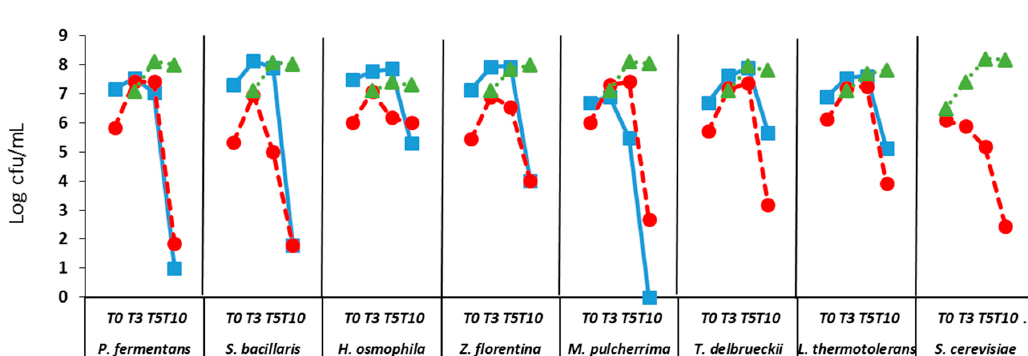
Figure 1. Growth of inoculated non- Saccharomyces ( ■ ), other non- Saccharomyces yeasts ( ● ) and S. cerevisiae ( ▲ ). Viable plate counts were done immediately after (T0), and 3, 5, and 10 days after inoculation (T3, T5, and T10, respectively). Data are means ±SD ( n = 2).